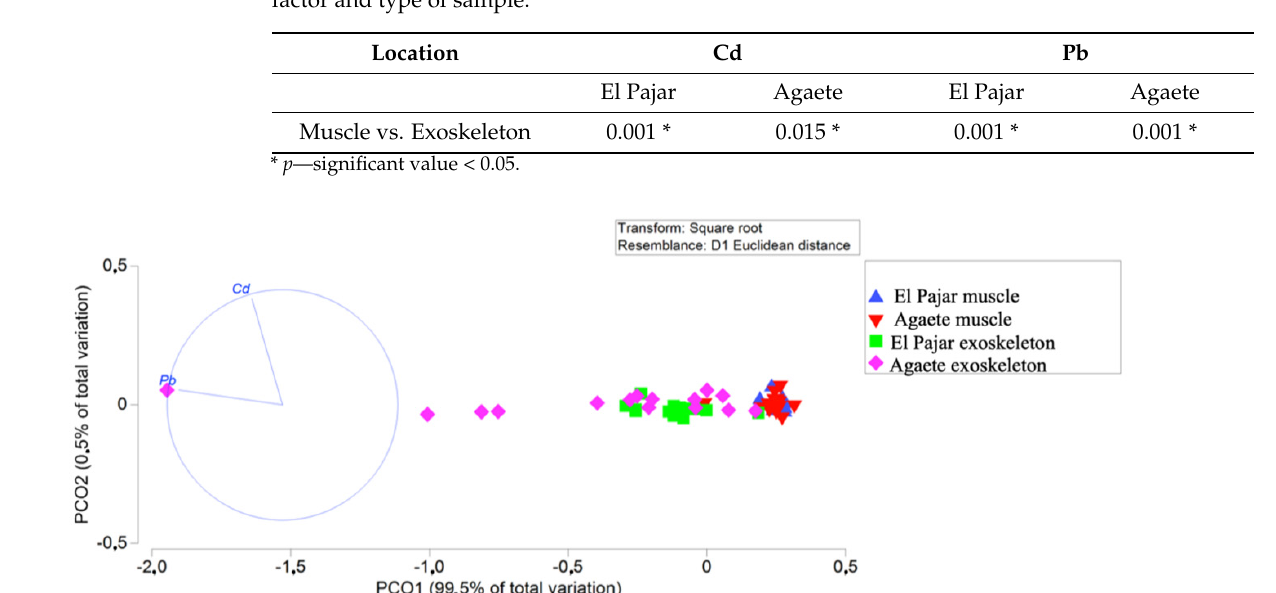
Figure 7. Principal Coordinate Analysis (PCoA) of muscle tissue and exoskeleton with the location factor and type of sample.